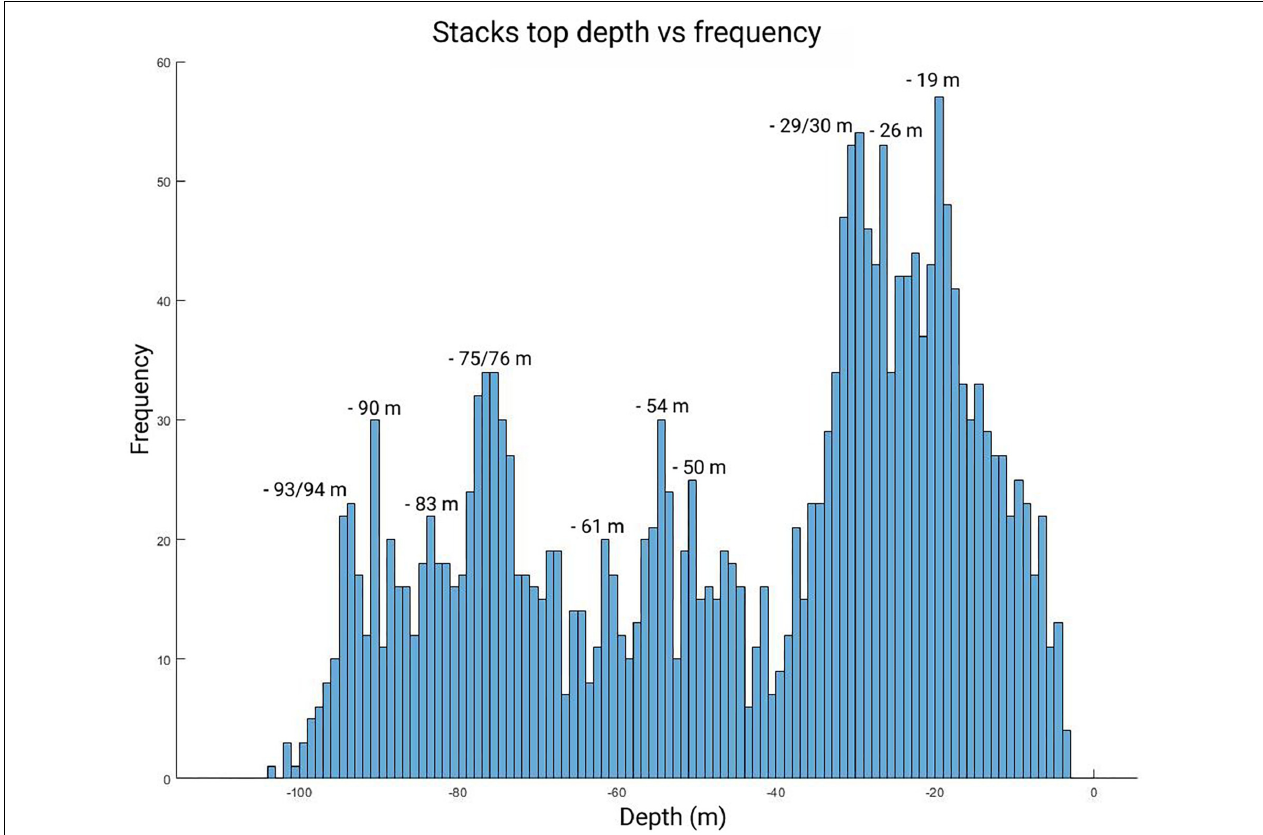
FIGURE 6 | Sea-stacks top depth and frequency. At –19, –26, –29/30, –50, –54, –61, –75/76, –83, –90, and –93/–94 m the number of peaks is higher. Moreover, there is a difference in the number of stacks on shallower and deeper than ∼ –32